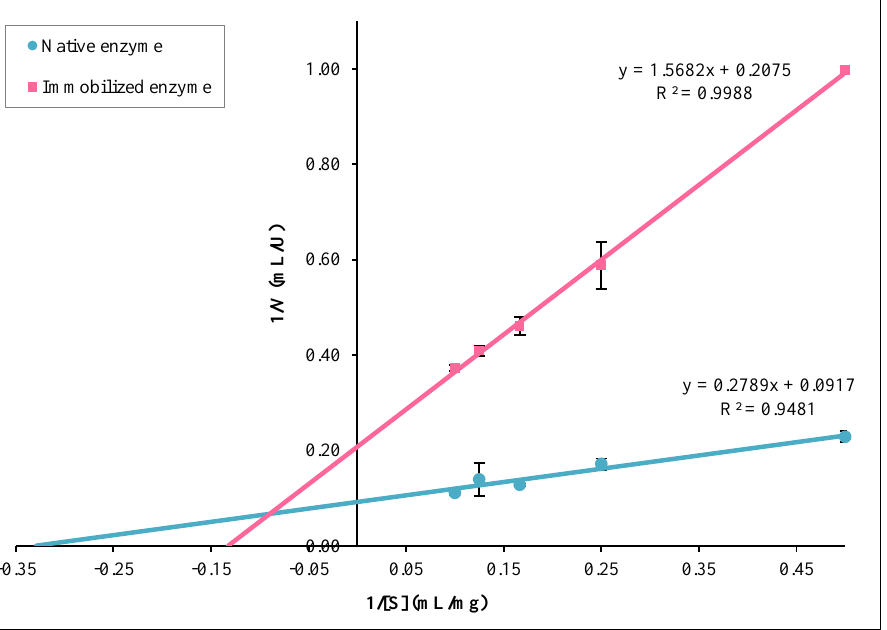
Figure 5. The Lineweaver-Burk plots for native and immobilized enzyme, constructed from the experimental results conducted at optimum temperature and the starch concentrations from 2.0 to 10.0 mg/mL Table 2. Kinetic parameters for the native and immobilized A. fumigatus α-amylase on different matrices Matrix